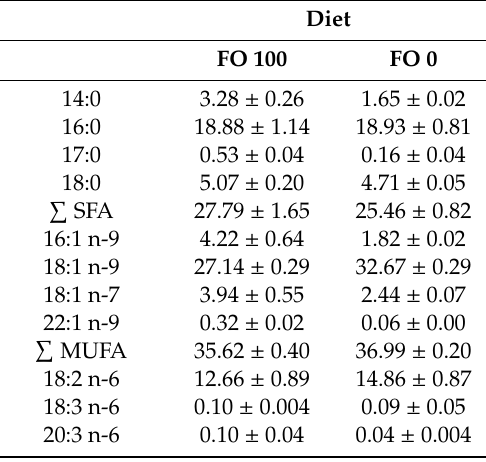
Table 7. Fatty acid composition (% of total fatty acid content) of the experimental